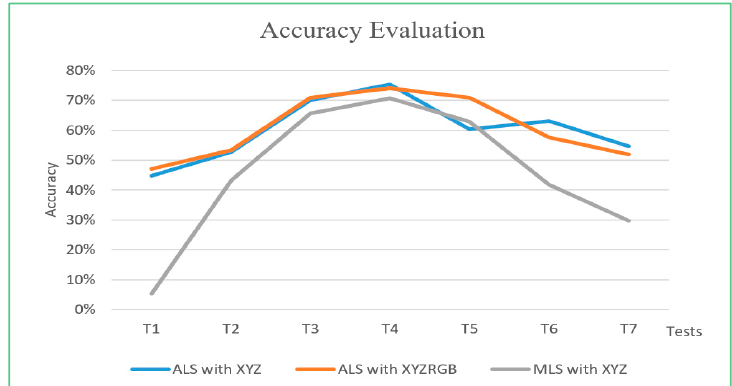
Figure 17. Accuracy graph for estimated ε (T4), radii gradually lower than ε (T3, T2, T1) and gradually greater than ε (T5, T6, T7).